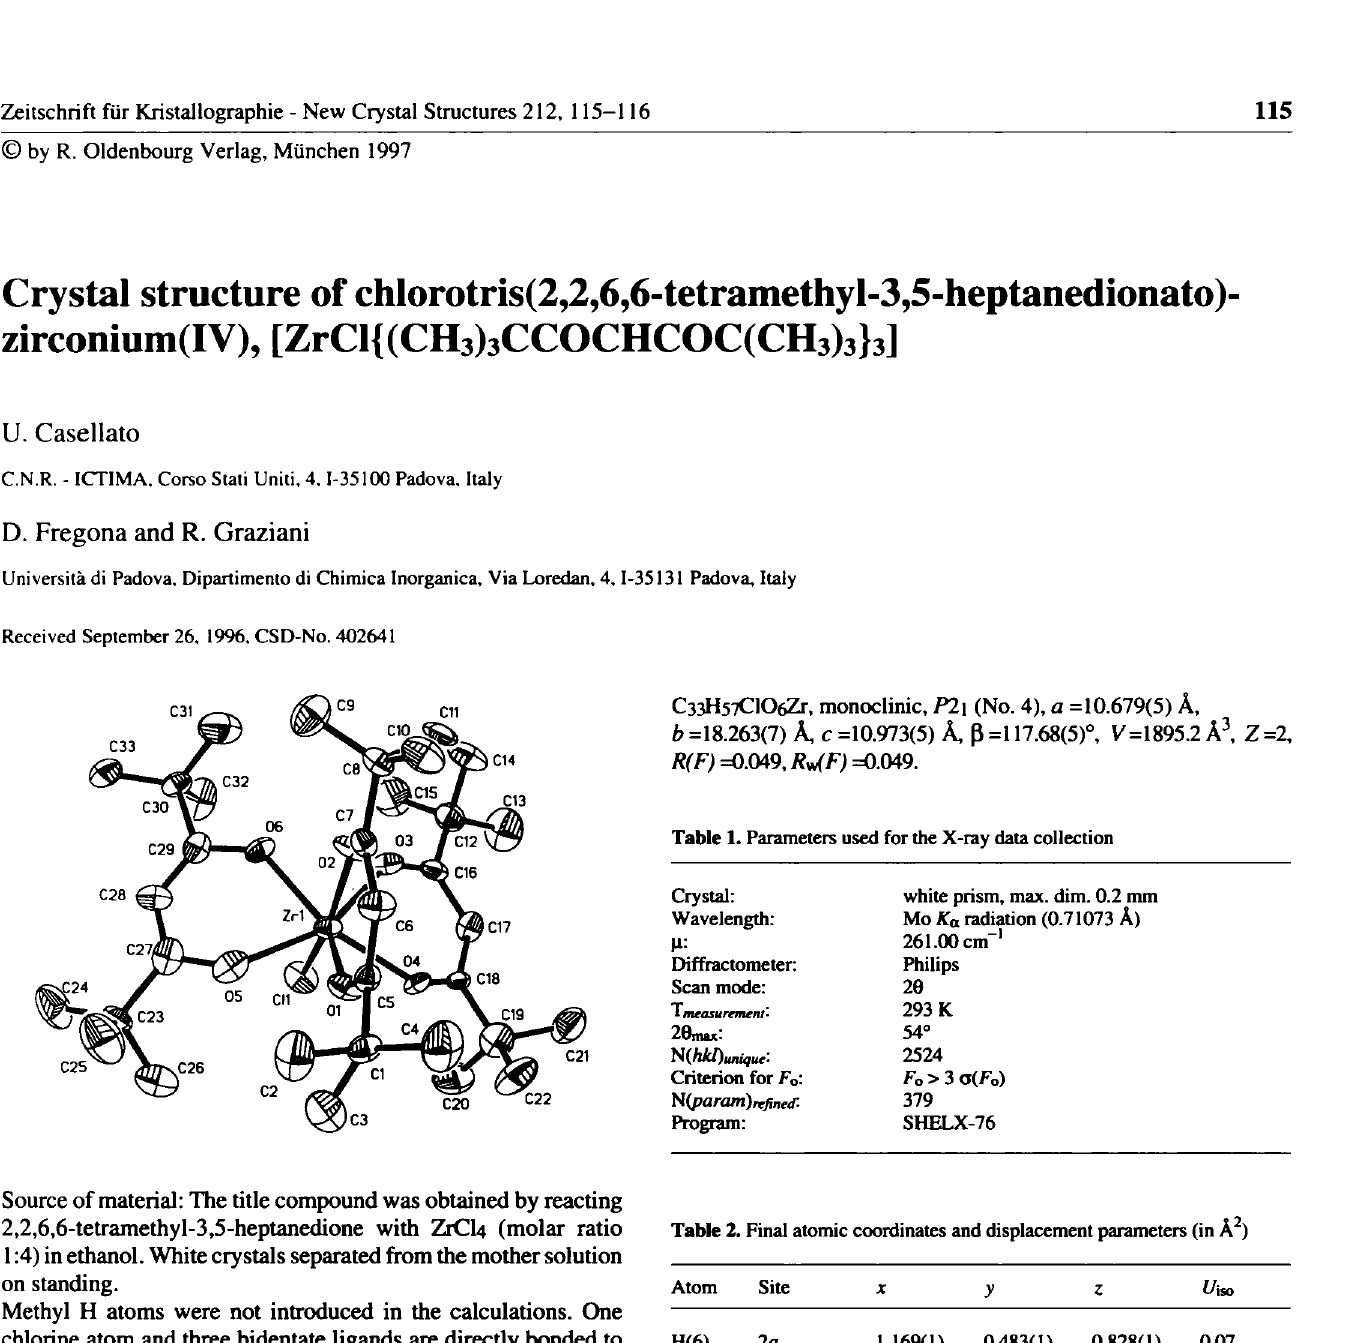
Table 2. Final atomic coordinates and displacement parameters (in Â 2